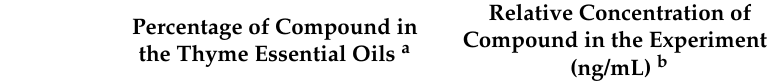
Table 2. Percentage (%) and relative concentrations (ng/mL) of the compounds of TEOs prepared at the beginning and at the end of the flowering period.